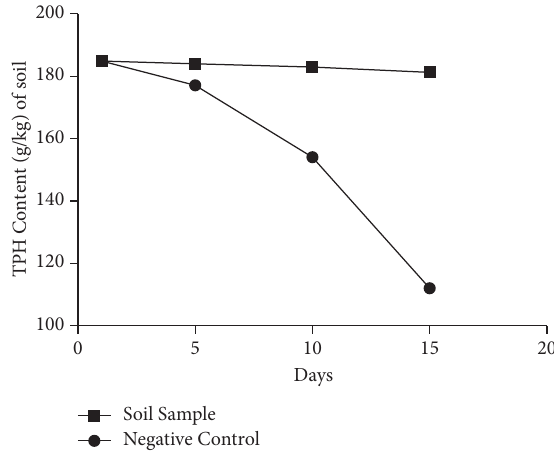
Figure 5: Biodegradation of Bacillus isolates M28, M29, ST70, and ST55 on contaminated